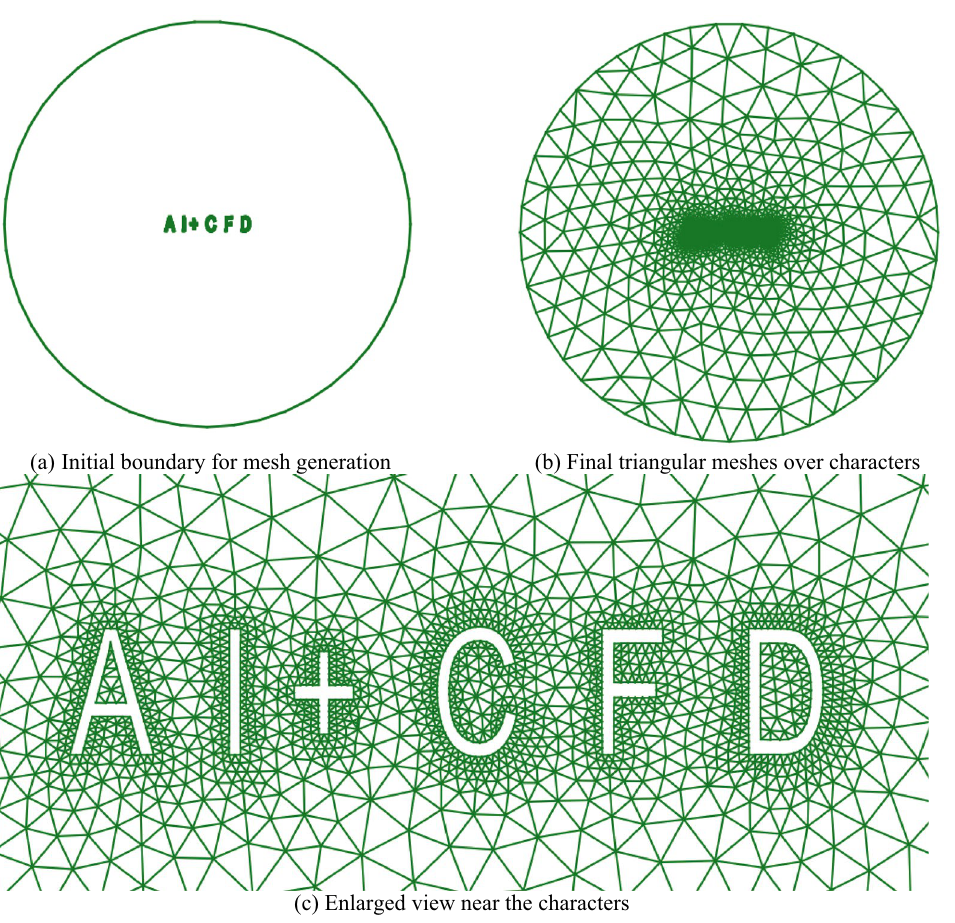
Figure 15. Isotropic triangular mesh over some special